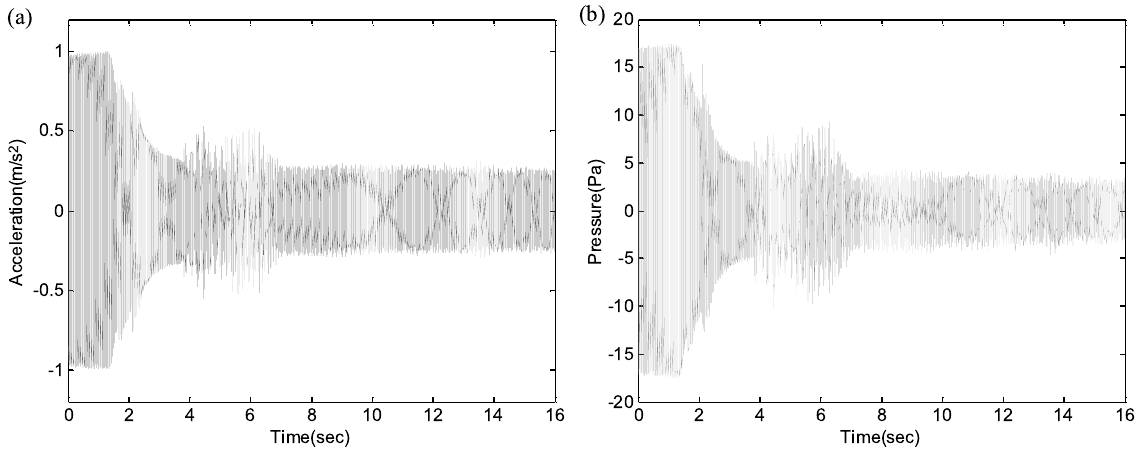
Fig. 12. Measured responses (control action is turned on at 1.4 s), a) summed acceleration; b) sound pressure.